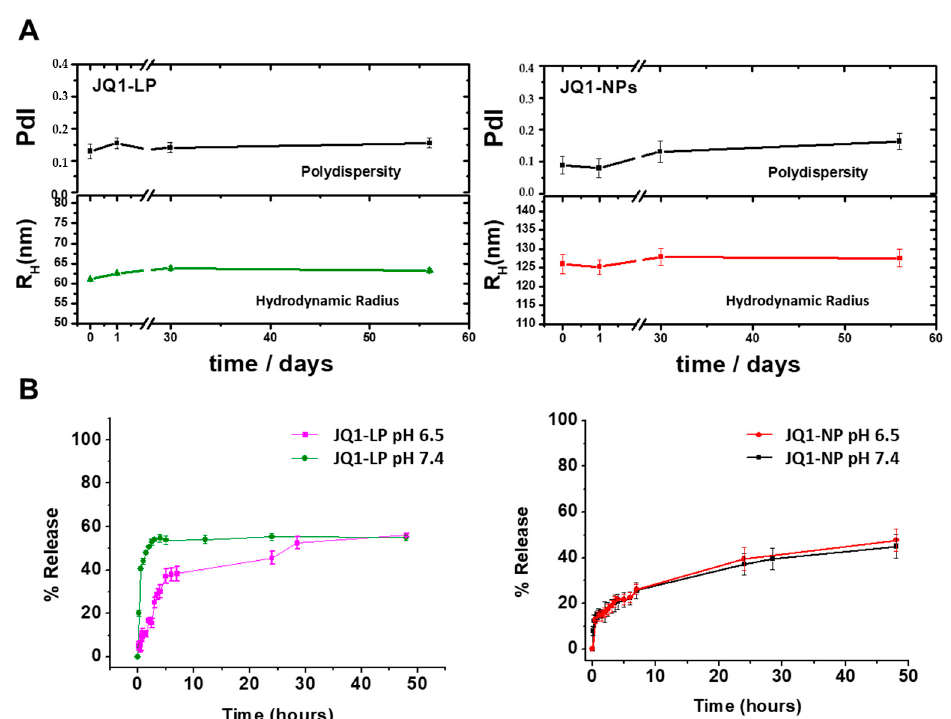
Figure 2. Storage stability and in vitro release profiles of JQ1-loaded nanodevices. ( A ) DLS analysis showing the stability of nanodevices. ( B ) Release kinetics of nanodevices in PBS (pH 7.4 and pH 6.5) at 37 °C. Data are expressed as mean ± SEM from at least three independent experiments.